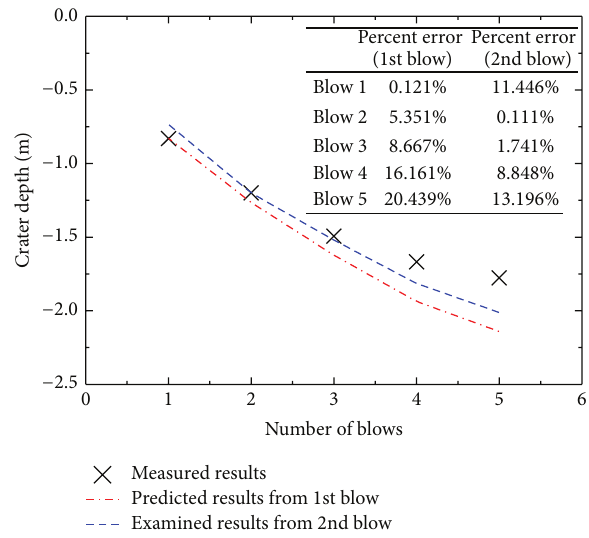
Figure 14: Measured and simulated pore water pressure in depth at impact location A.